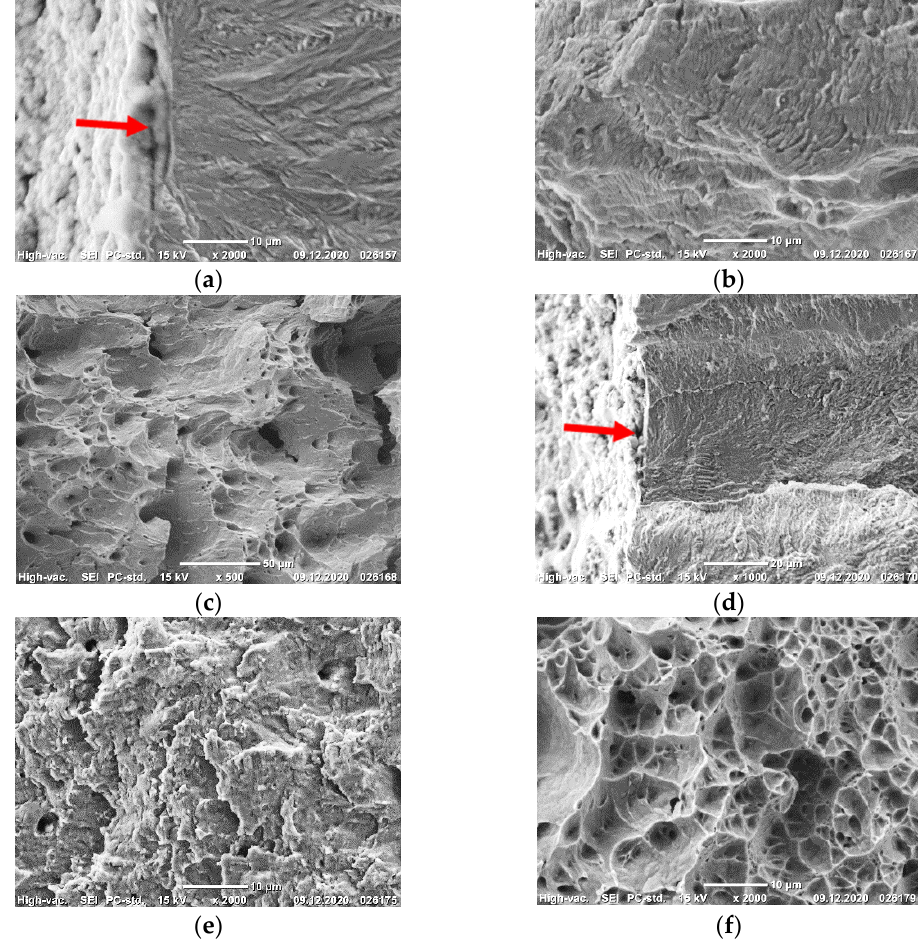
Figure 9. Microrelief of the fatigue fracture surface of the CG ( a – c ) and UFG ( d – f ) steel in the vicinity of the fracture nucleus ( a , d ), in the middle area of the crack length ( b , e ) and in the final failure zone ( c , f ). The fatigue fracture nucleus is indicated by arrows. The direction of crack propagation is from left to right. ( а , b , e , f )—×2000; ( c )—×500; ( d )—×1000.